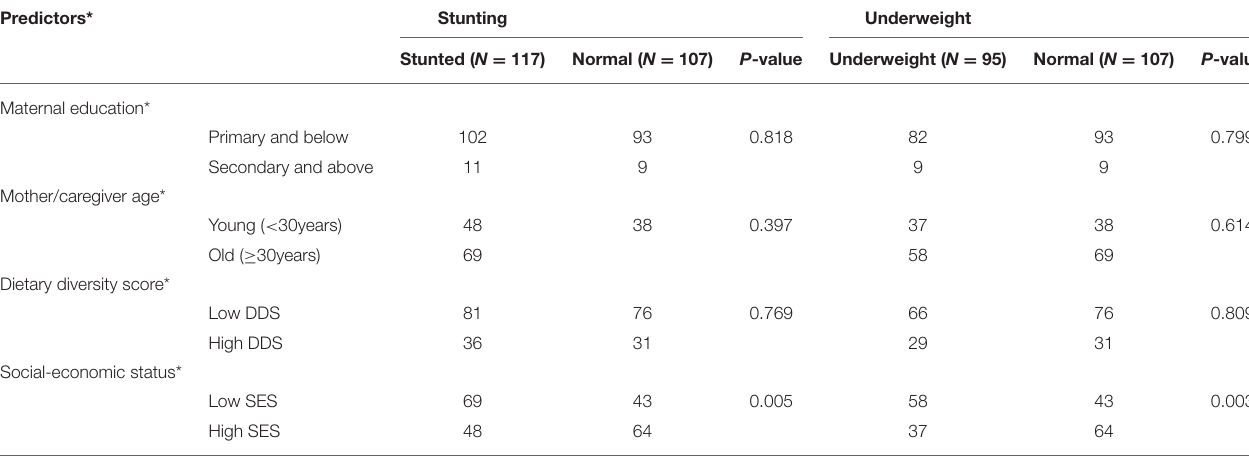
TABLE 3 | Relationship of participant undernutrition with reported maternal education, mother or caregiver age, child’s dietary diversity score, and household socioeconomic status.